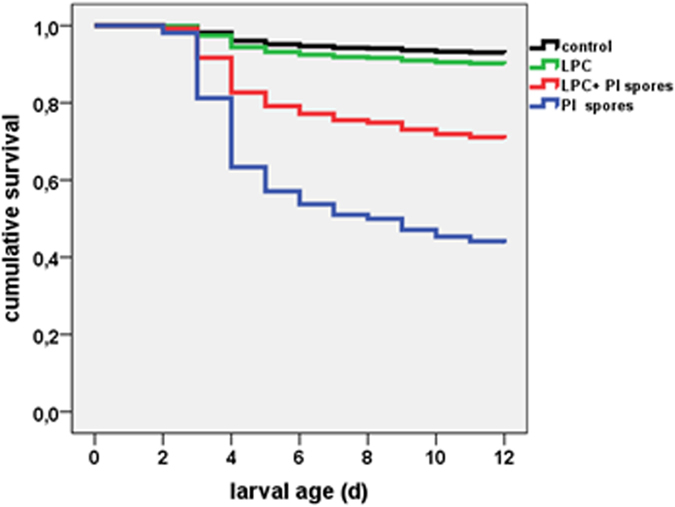
Cumulative survival rate of honeybee larvae.Control; fed with LPC (10 µg/d on day 1, 2 and 3); inoculated with P. larvae spores and treated with LPC (10 µg/d on day 1, 2 and 3) and larvae inoculated with P. larvae spores without treatment. The observation period was 12 d. Replicates: control (48/48/48/48/48/47). LPC (70/48/48/47/40), LPC + spores (71/48/48), spores (71/48/48).